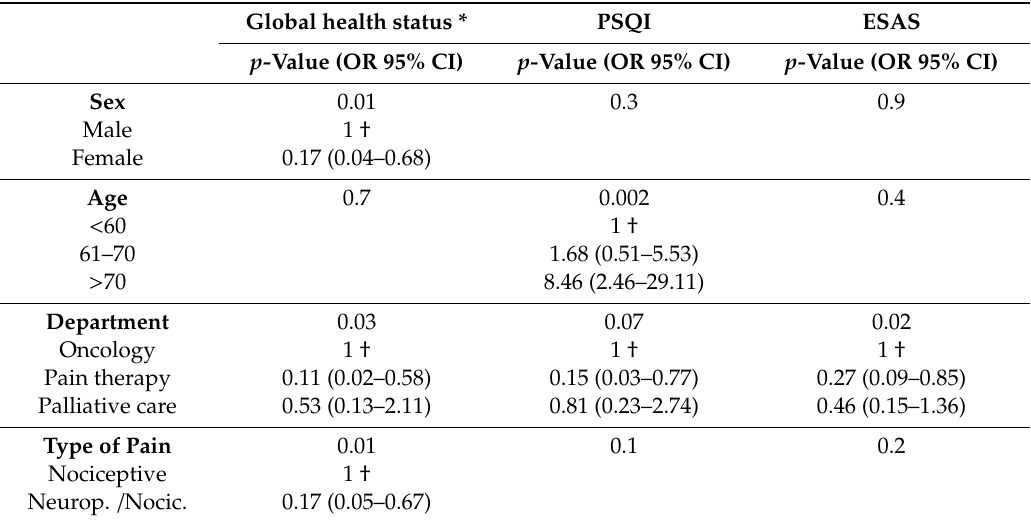
Table 5. Adjusted logistic regression analysis on improvedˆ